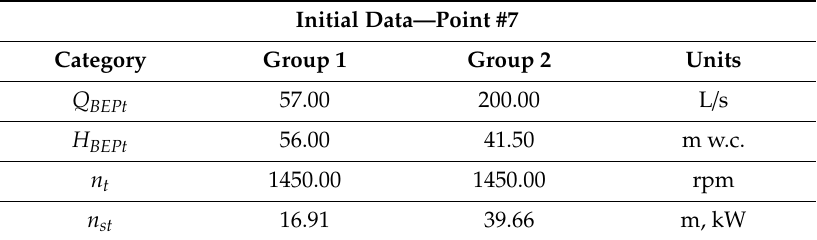
Table 10. Initial data for conversion from point #7.